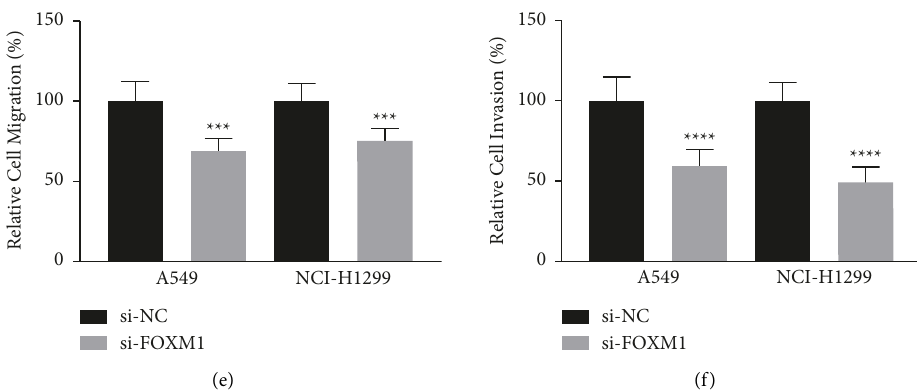
Figure 4: Knockdown of FOXM1 inhibits the progression of NSCLC cells. A549 and NCI-H1299cells transfected with si-NC or si-FOXM1, respectively. (a) FOXM1 mRNA levels were assayed in transfected A549 and NCI-H1299 cells. (b) FOXM1 protein levels were evaluated in transfected A549 and NCI-H1299 cells. The proliferation abilities of transfected A549 (c) and NCI-H1299 cells (d). (e) Migration assays of transfected A549 and NCI-H1299 cells. (f) Invasion assays of transfected A549 and NCI-H1299 cells. ∗ P < 0 . 05, ∗∗ P < 0 . 01, ∗∗∗ P < 0 . 001, and ∗∗∗∗ P < 0 .